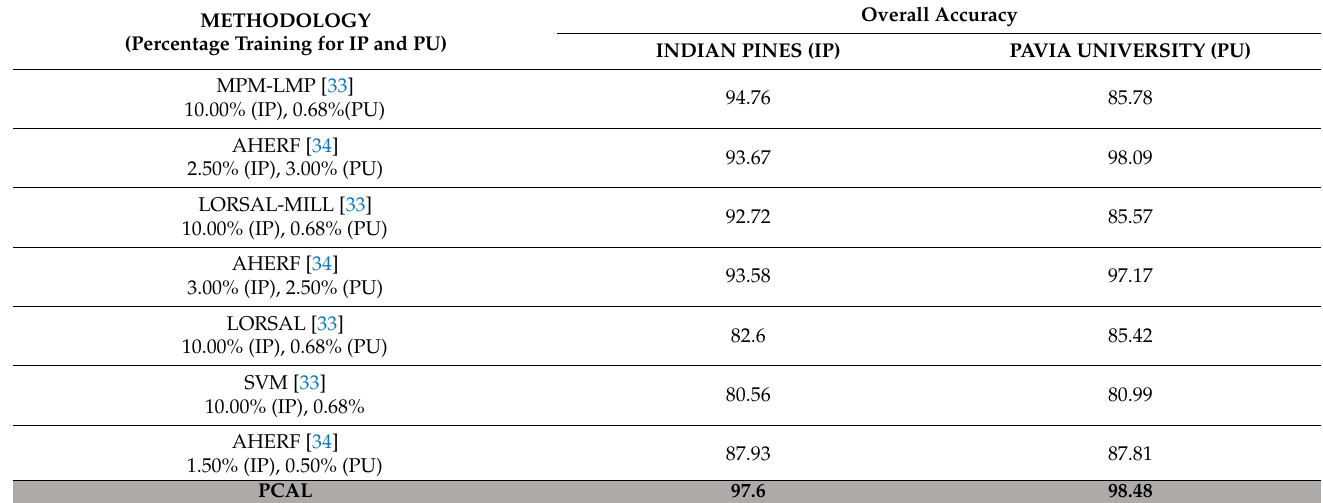
Table 6. Overall accuracy.